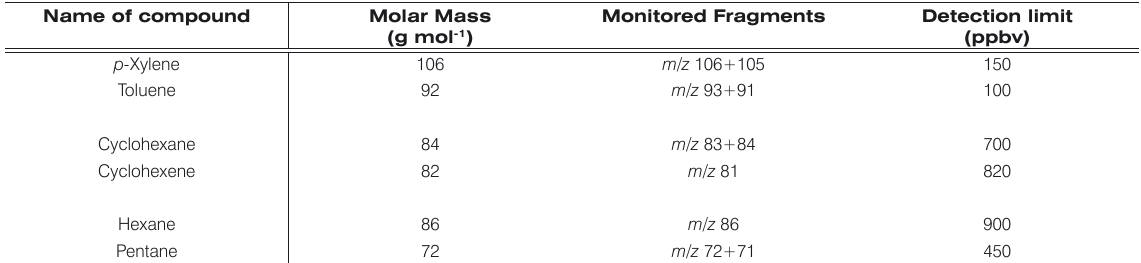
CN as a chemical ionization reagent. 3